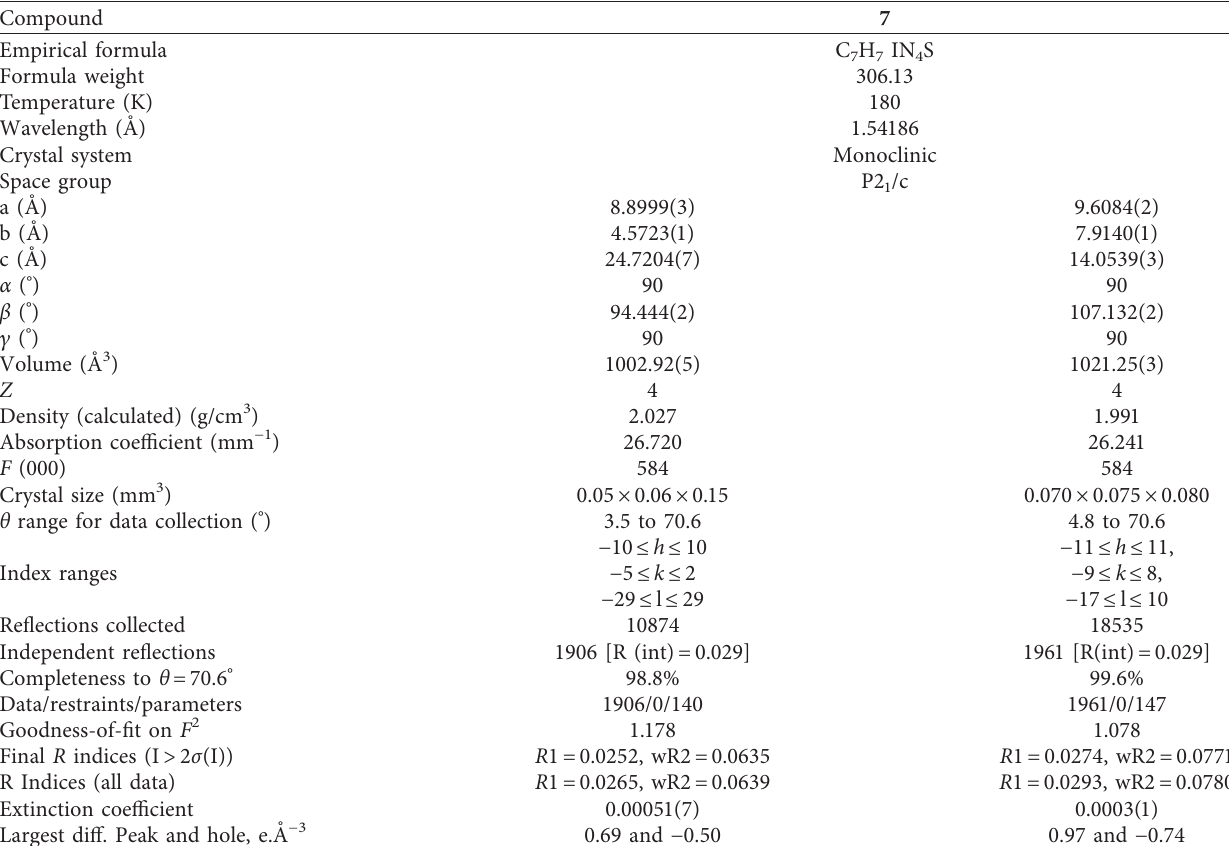
Table 1: Crystal and structure refinement data of 7 obtained as rod-like (left column) and plate-like crystals (right